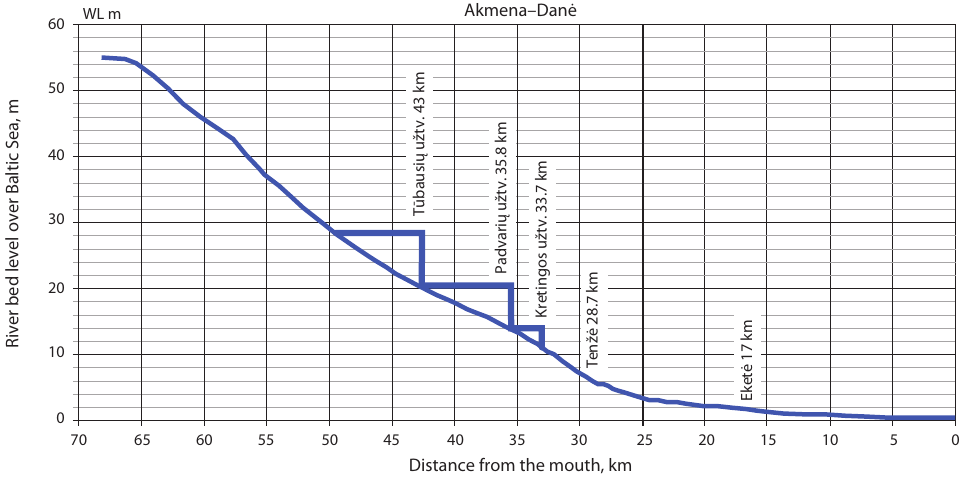
Fig. 3. Topographic profile of Akmena-Danė river gradient and major